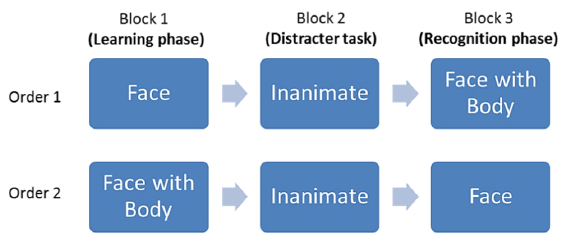
Figure 2. The orders of stimulus presentation in three sep- arate